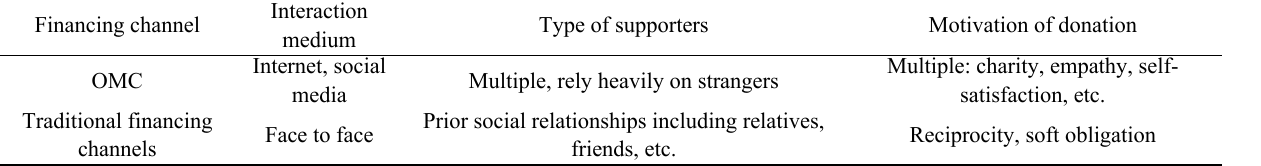
Table 1 Comparison of OMC and traditional financing